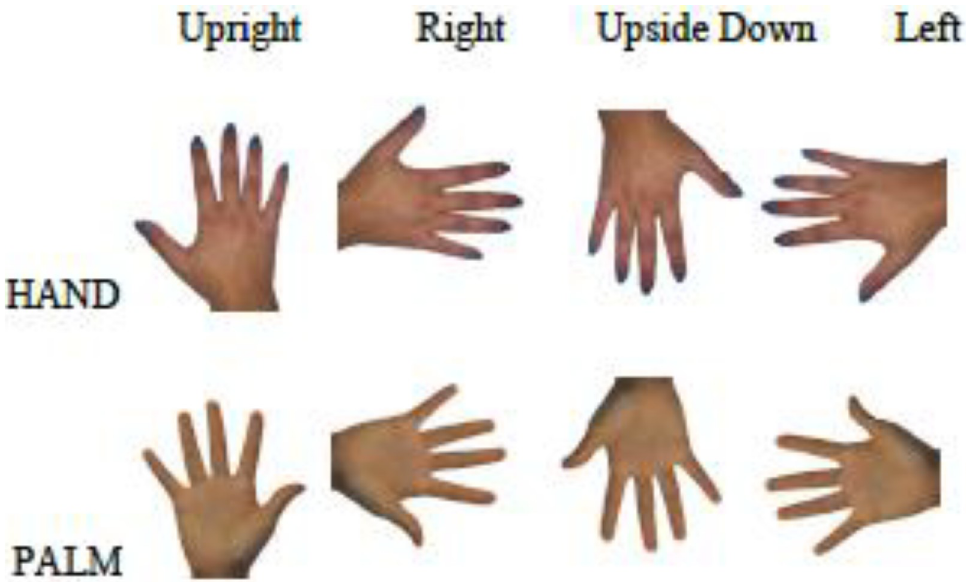
Fig 1. Sample images for the dorsum and palm in each orientation used. The four orientations are shown, from left to right, in the order of (1) upright (0˚), (2) to the right (90˚), (3) upside down (180˚), and (4) to the left (270˚) for the dorsum (top row) and palm (bottom